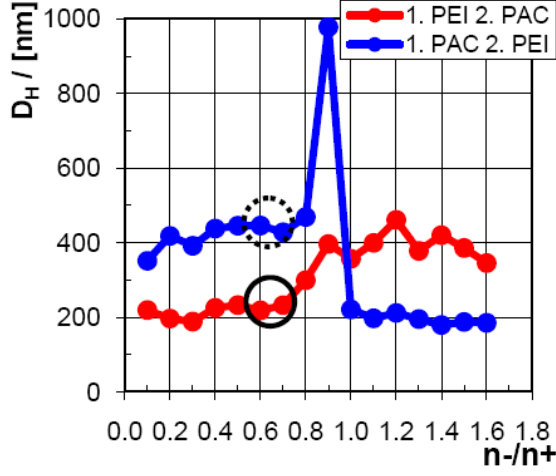
/n , c = 0.001 M, pH = − + PEL